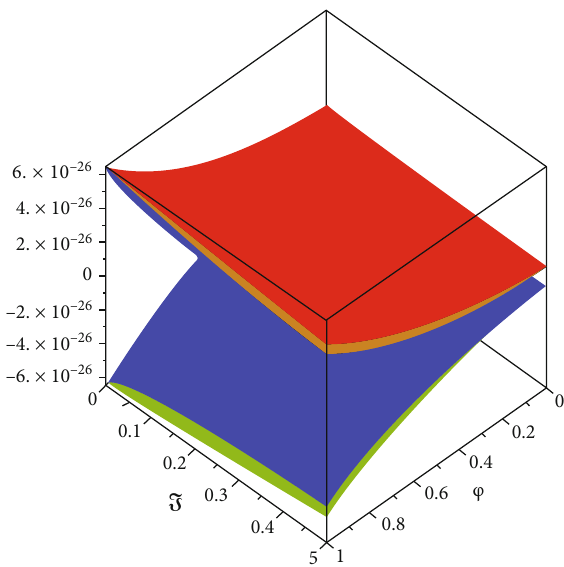
Figure 7: The three-dimensional fuzzy lower and upper branch graph of the di ff erent fractional-order of ϱ .